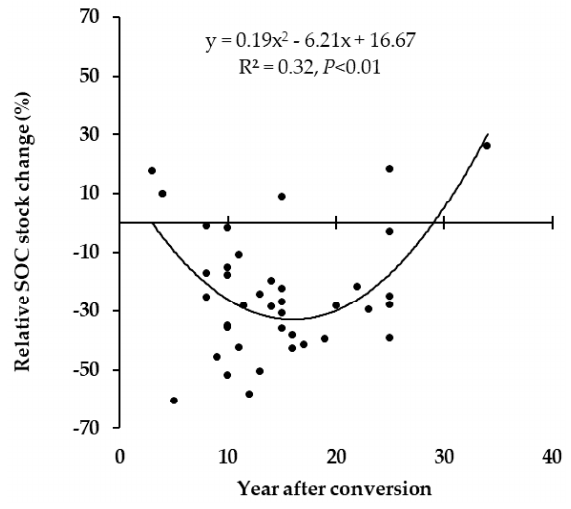
Figure 2. Relative SOC stock change over 35 years after conversion from primary forest to oil palm plantation (data source: Tables S1–S4) in tropical mineral soils.